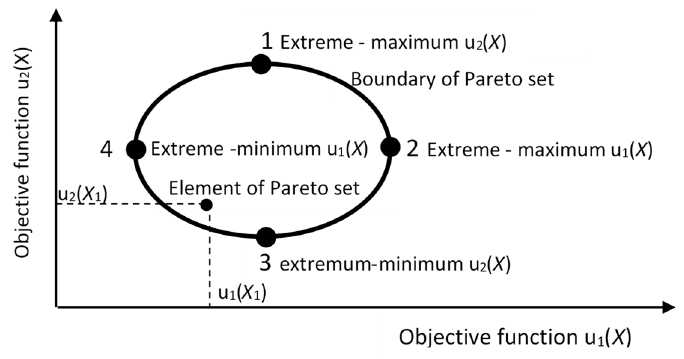
Figure 1. Scheme of Pareto set (redrawn according to [16]).